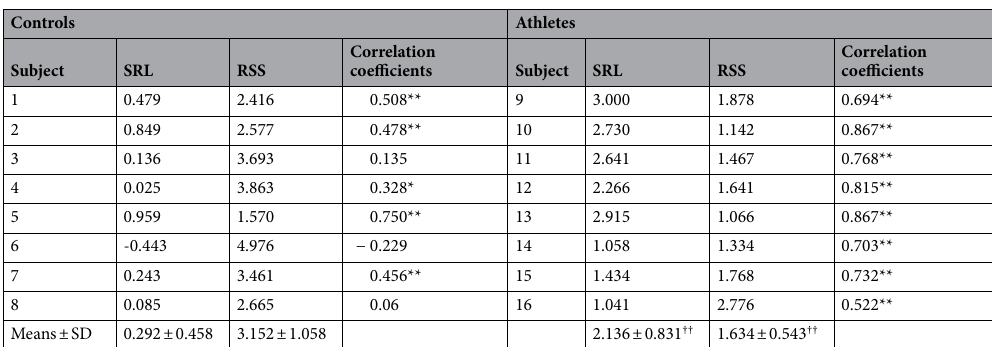
Table 2. Data of correlation coefficient, SRL, RSS for each subject, in controls and athletes, and average values of SRL and RSS for both groups. *p < 0.05, **p < 0.01: statistical significance for correlation coefficient. †† p < 0.01: vs.